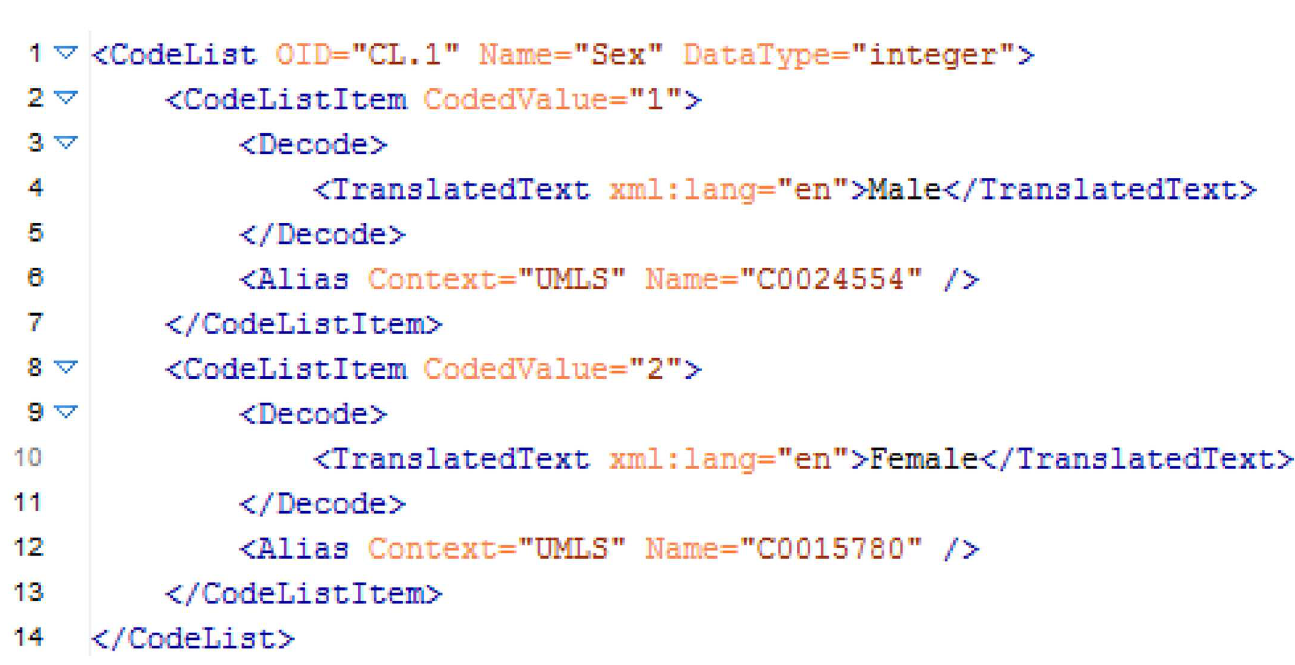
Fig 2. An exemplary code list definition for the item sex in ODM